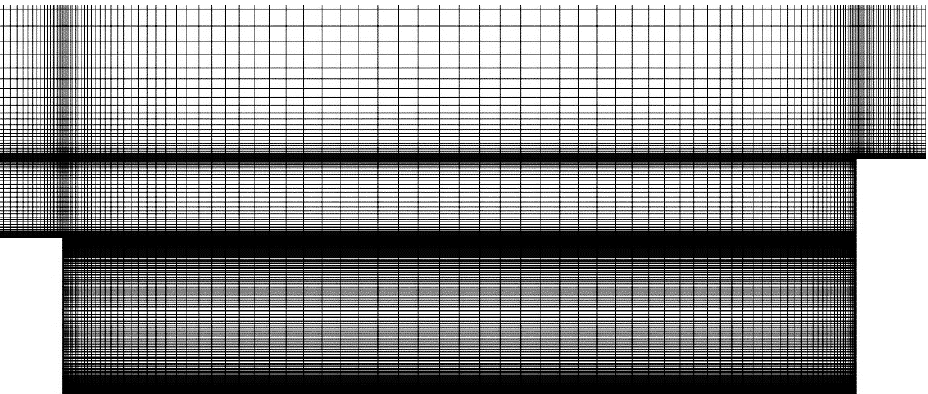
Figure 4. Mesh distribution of the computational domain.